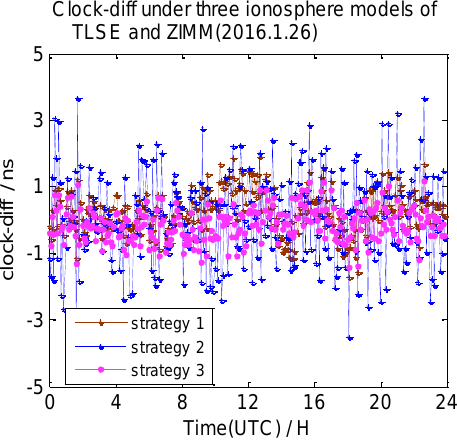
Figure 14. The clock difference under three ionosphere methods of TLSE and ZIMM.